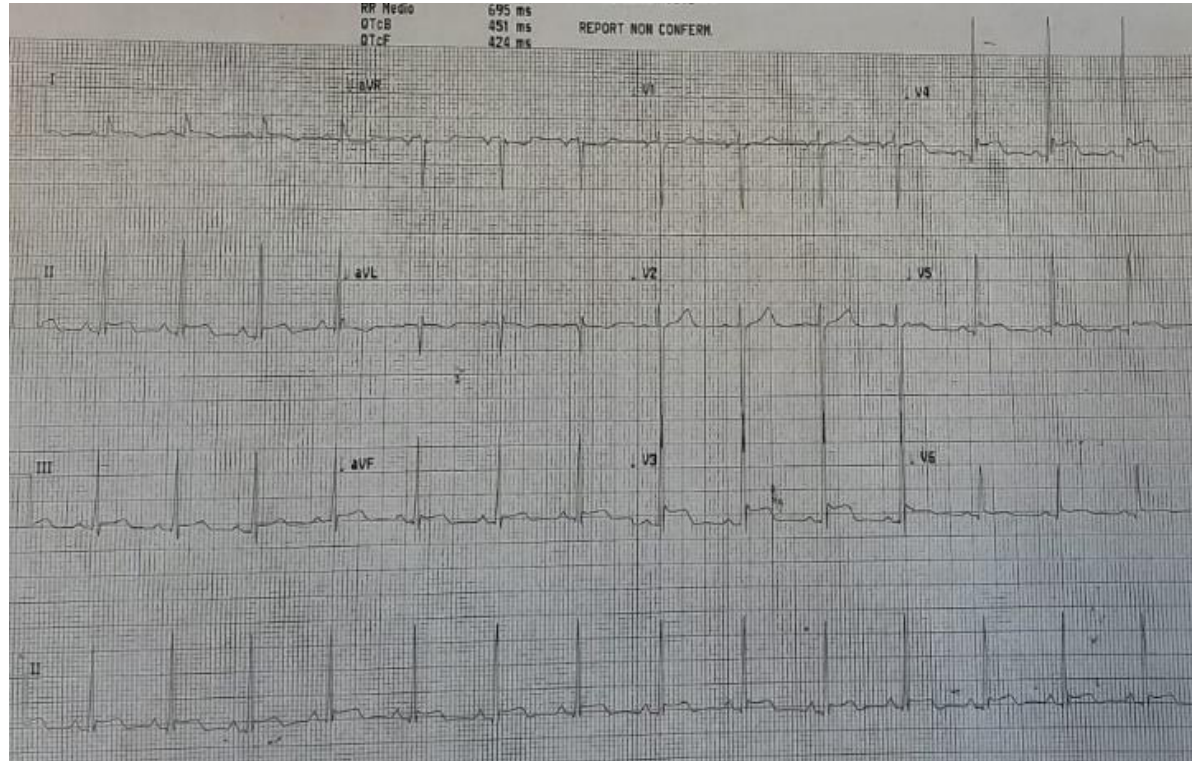
Figure 1. ECG at admission, with diffuse ST elevation.